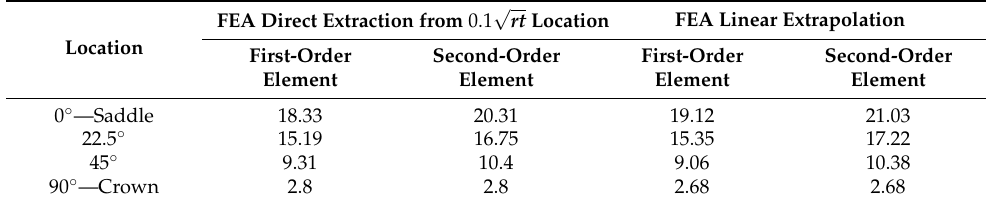
Figure 16. Experimental mean SCF values against FE SCF values. Table 6. Circumferential variation of extracted SCF by direct and linear extrapolation methods for first and second-order